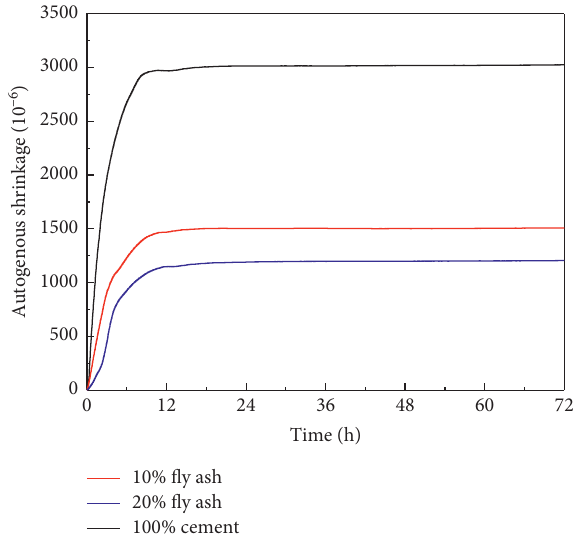
Figure 15: Effect of PCE-2 and fly ash dosage on autogenous shrinkage of cement mortar.